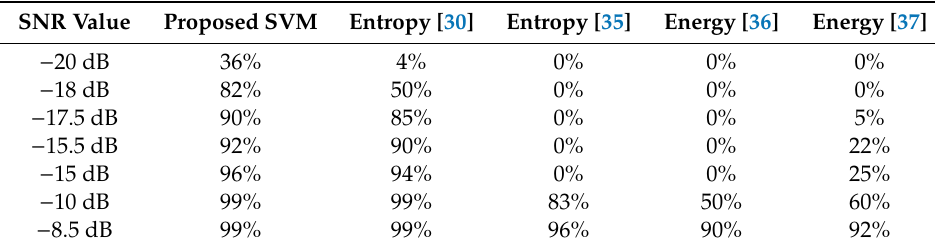
Table 3. Probability of detection vs. SNR